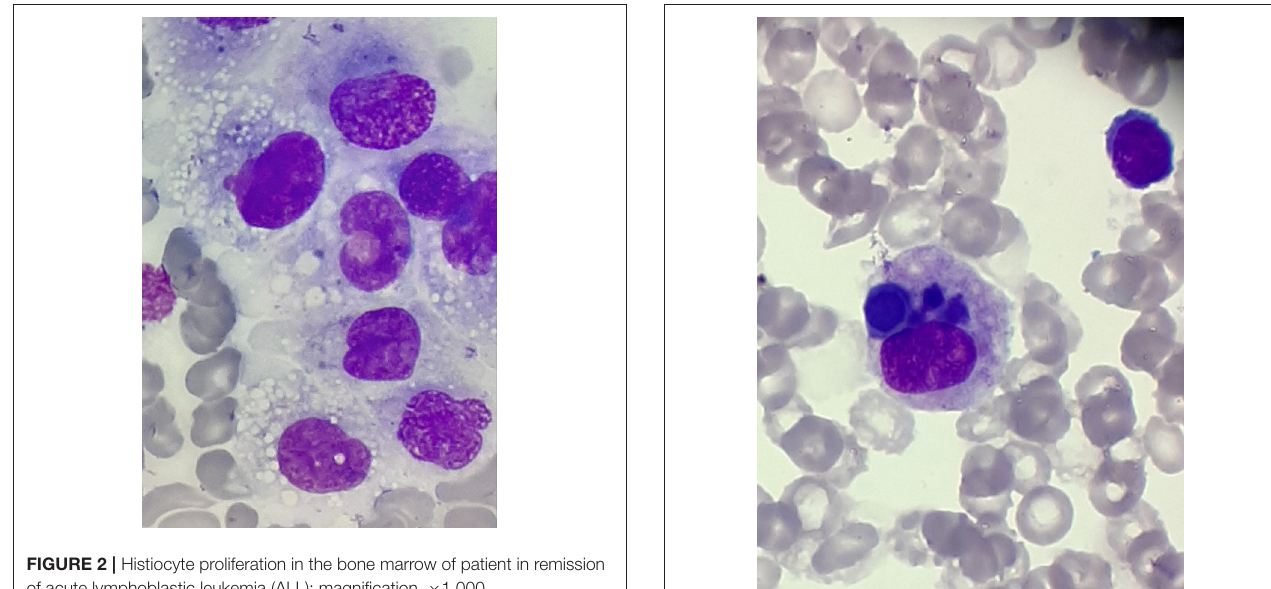
FIGURE 3 | Hemophagocytosis in bone marrow; magnification, ×